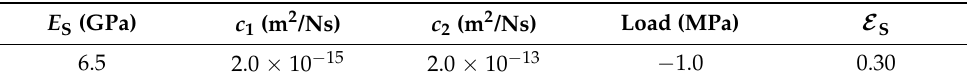
Table 3. Input data used in the rheological model shown in Figure 8. Calculated evolution of strain: Figure